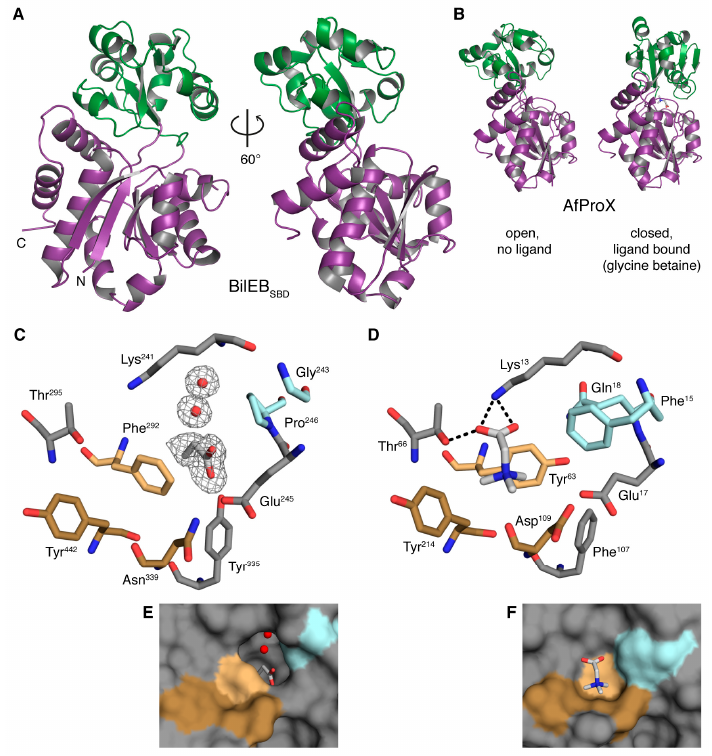
Figure 3. Comparison of the crystal structures of BilEB SBD and A. fulgidus ProX: ( A , B ) BilEB SBD and AfProX in cartoon representation with domain A of each protein in purple and domain B in green. Both the open and closed conformations of ProX are shown (PDB ID 1SW5 and 1SW2, respectively) in order to demonstrate the movement of domains during substrate binding. ( C , D ) Binding site residues from domain A of ( C ) BilEB SBD and ( D ) AfProX (PDB ID 1SW5). Amino acid residues and ligands are shown in stick representation with oxygens colored red and nitrogens colored blue. Propanoic acid and glycine betaine are colored white. Bound water molecules are shown as red spheres. Residues forming a cage around the quaternary ammonium are dark gold except for the position corresponding to Phe 292 in BilEB SBD , which is pale gold. Residues corresponding to Gly 243 and Pro 246 in BilEB SBD are colored pale blue. The grey mesh in ( C ) is an omit Fo-Fc electron density map contoured at 2.0 σ . Dashed lines indicate hydrogen bonds or salt bridges. ( E , F ) The same view as ( C , D ), respectively, with the proteins shown in surface representation and domain B omitted for clarity. Images were prepared in PyMOL [52].